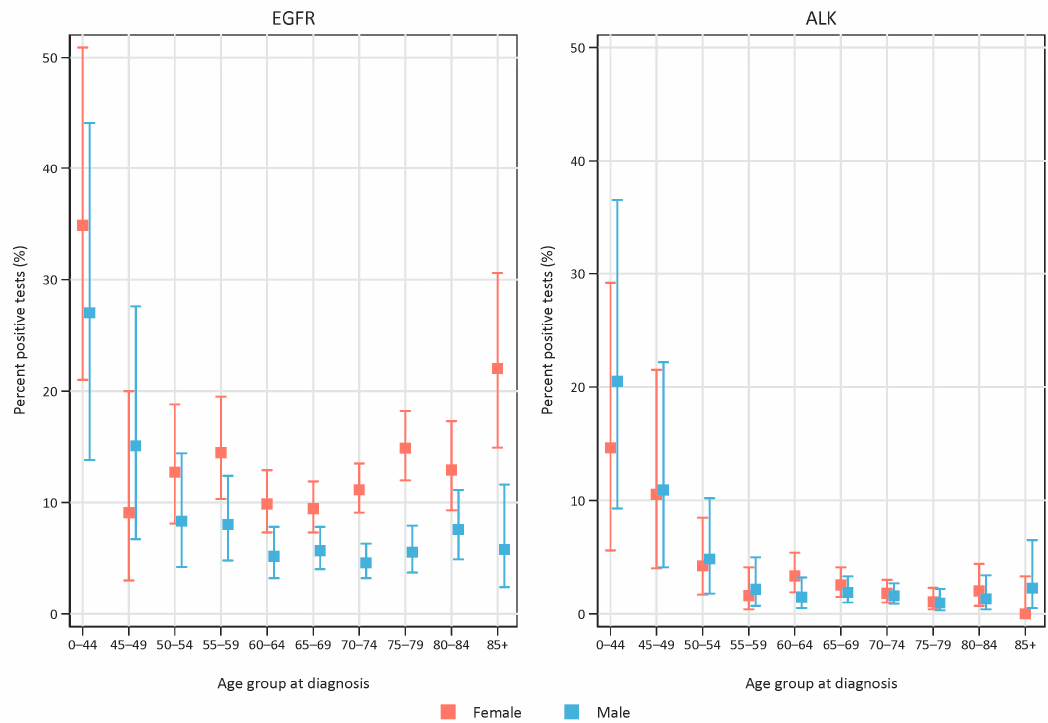
Figure 3. Fraction of positive test results among tested patients, related to age groups. Left panel represents EGFR tests and right panel represents ALK tests. Red symbols represent females and blue symbols represent males. Error bars represent 95% confidence interval.